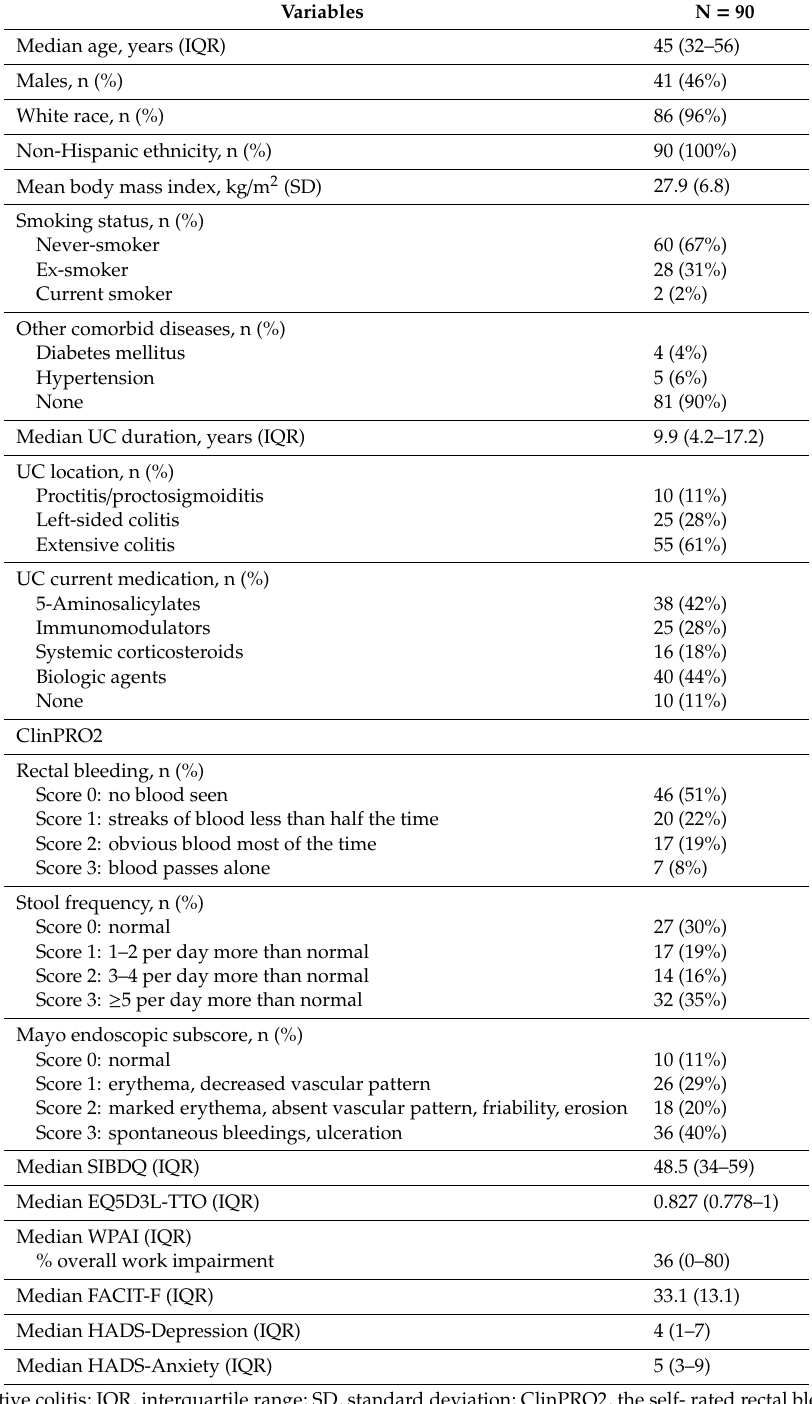
Table 1. Demographic and clinical characteristics of 90 patients with ulcerative